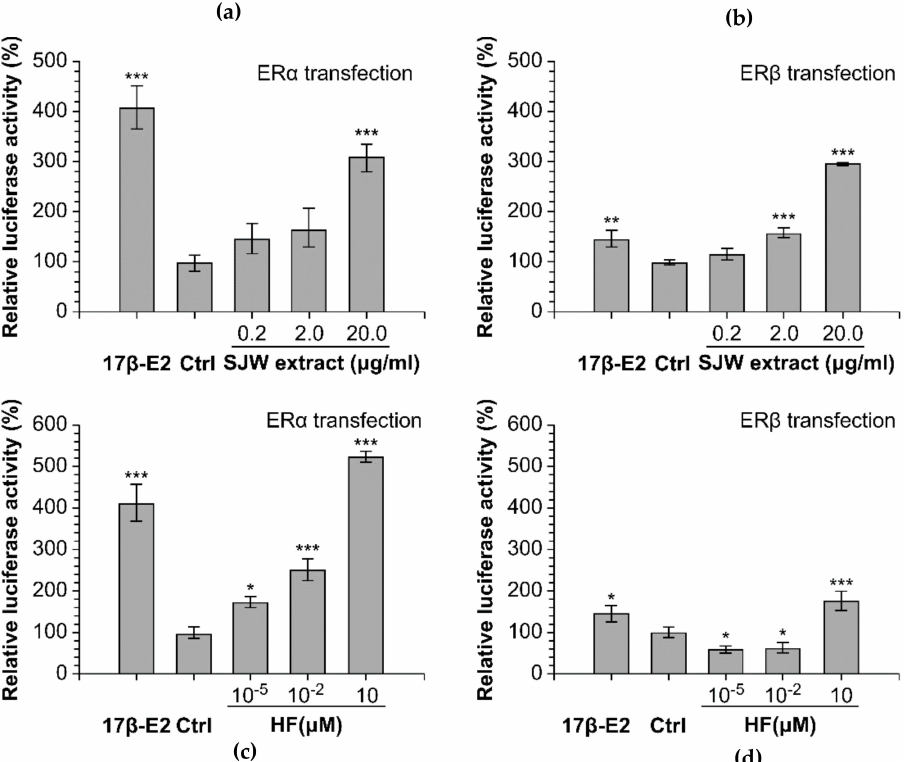
Figure 4. Effect of St. John’s wort (SJW) extract and hyperforin (HF) on estrogen receptor levels in MCF-7 cells. The luciferase activities in MCF-7 cells transfected with ER α ( a , c ) or ER β ( b , d ) were measured after treatment with 0.2 to 20 µ g/mL SJW extract ( a , b ) or 10 − 5 to 10 µ M HF ( c , d ). A positive control was prepared by treating the cells with 10 − 2 µ M 17 β -E2. Bars represent the averages of triplicate determinations. * p < 0.05 and *** p < 0.001. Reprinted from Kwon, J.; Oh